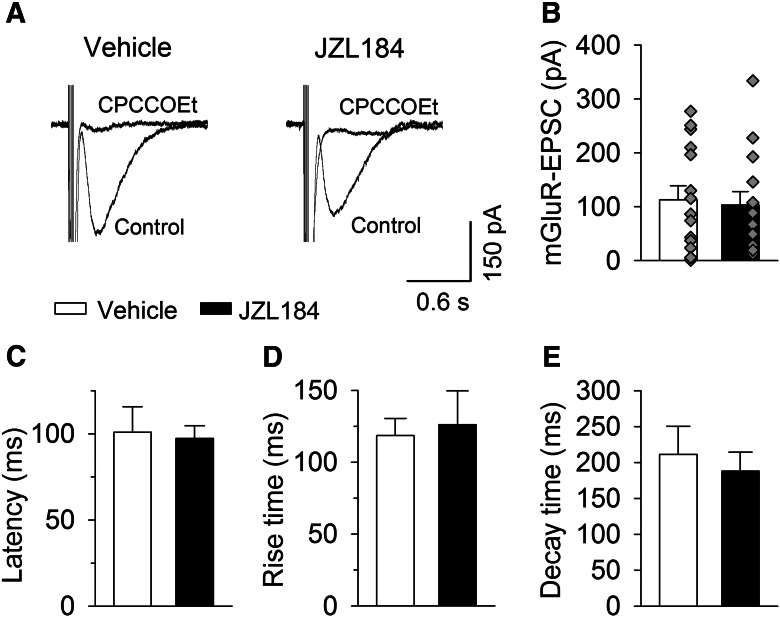
MAGL inhibitors JZL184 did not significantly alter mGluR1-EPSCs in PCs. A, A short burst (100 Hz, 5 stimuli) of stimulation of the molecular layer induced slow EPSCs in vehicle- and JZL184-treated slices, the slow EPSCs were blocked by mGluR1 antagonist CPCCOEt (100 µm; n = 3 each group). B–E, JZL184 treatment did not significantly changed the amplitude (B; n = 14–15; p = 0.781), the latency (C; n = 8–9; p = 0.833), rise time (D; n = 8–9; p = 0.731), and decay time constant (E; n = 8–9; p = 0.638) of mGluR1-EPSCs.